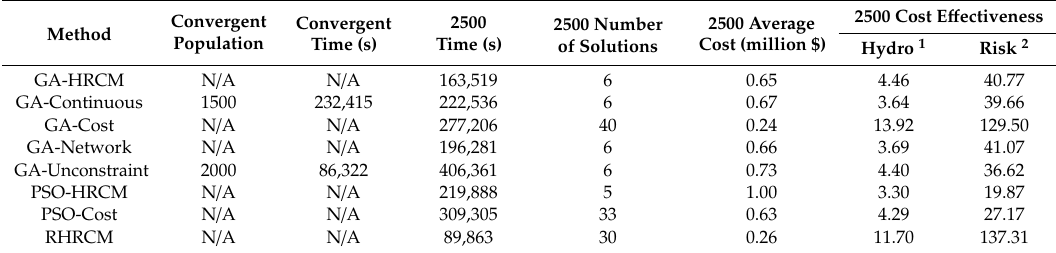
Table 5. The summarized results of seven methods with scenario